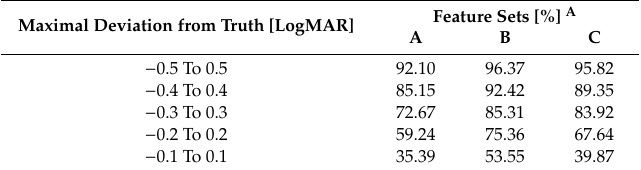
Table 2. Accuracy of predicting best corrected visual acuity